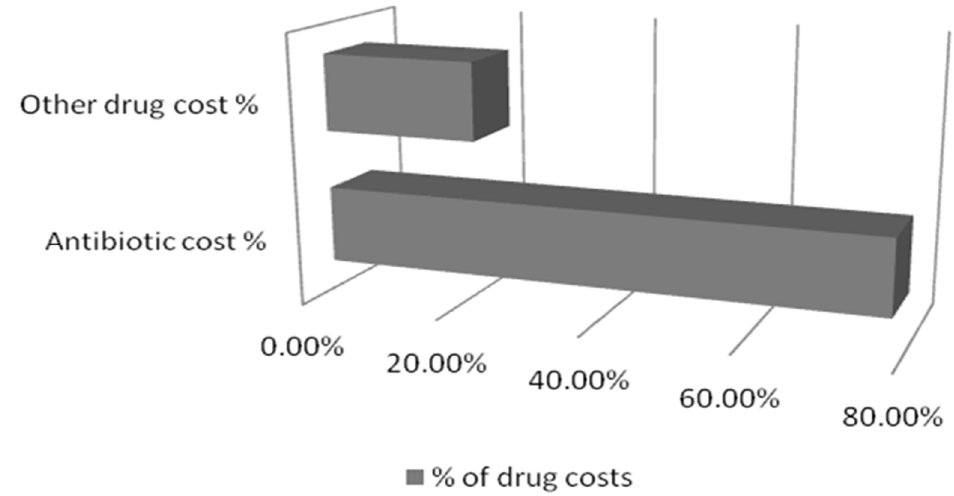
Figure 5. Antibiotic and other drug cost.